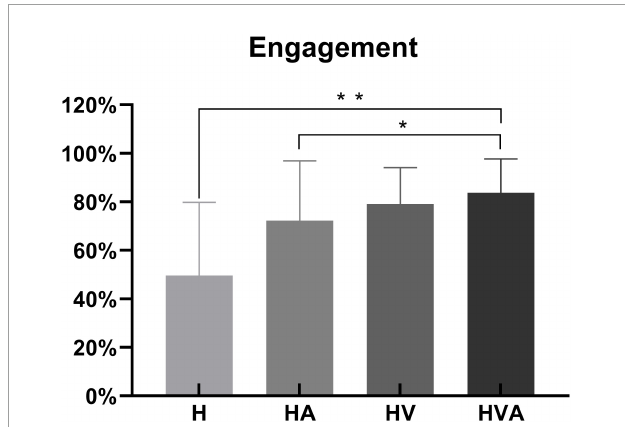
FIGURE4 Statistical analysis of the engagement under four experimental conditions. * p < 0.05, ** p < 0.01. The abbreviations in the figure represent haptic (H), haptic + auditory (HA), haptic + visual (HV), and haptic + visual + auditory (HVA).